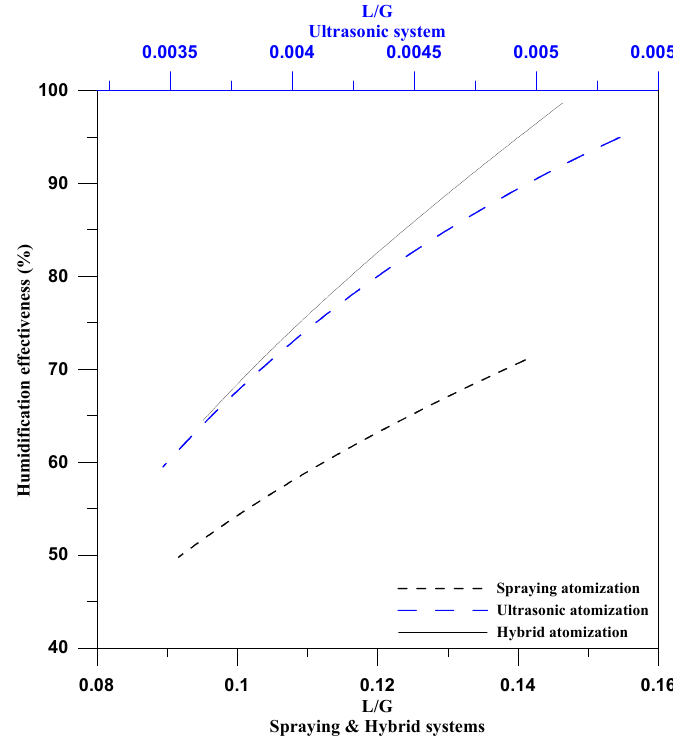
Figure 13. Comparison of the three humidification systems.